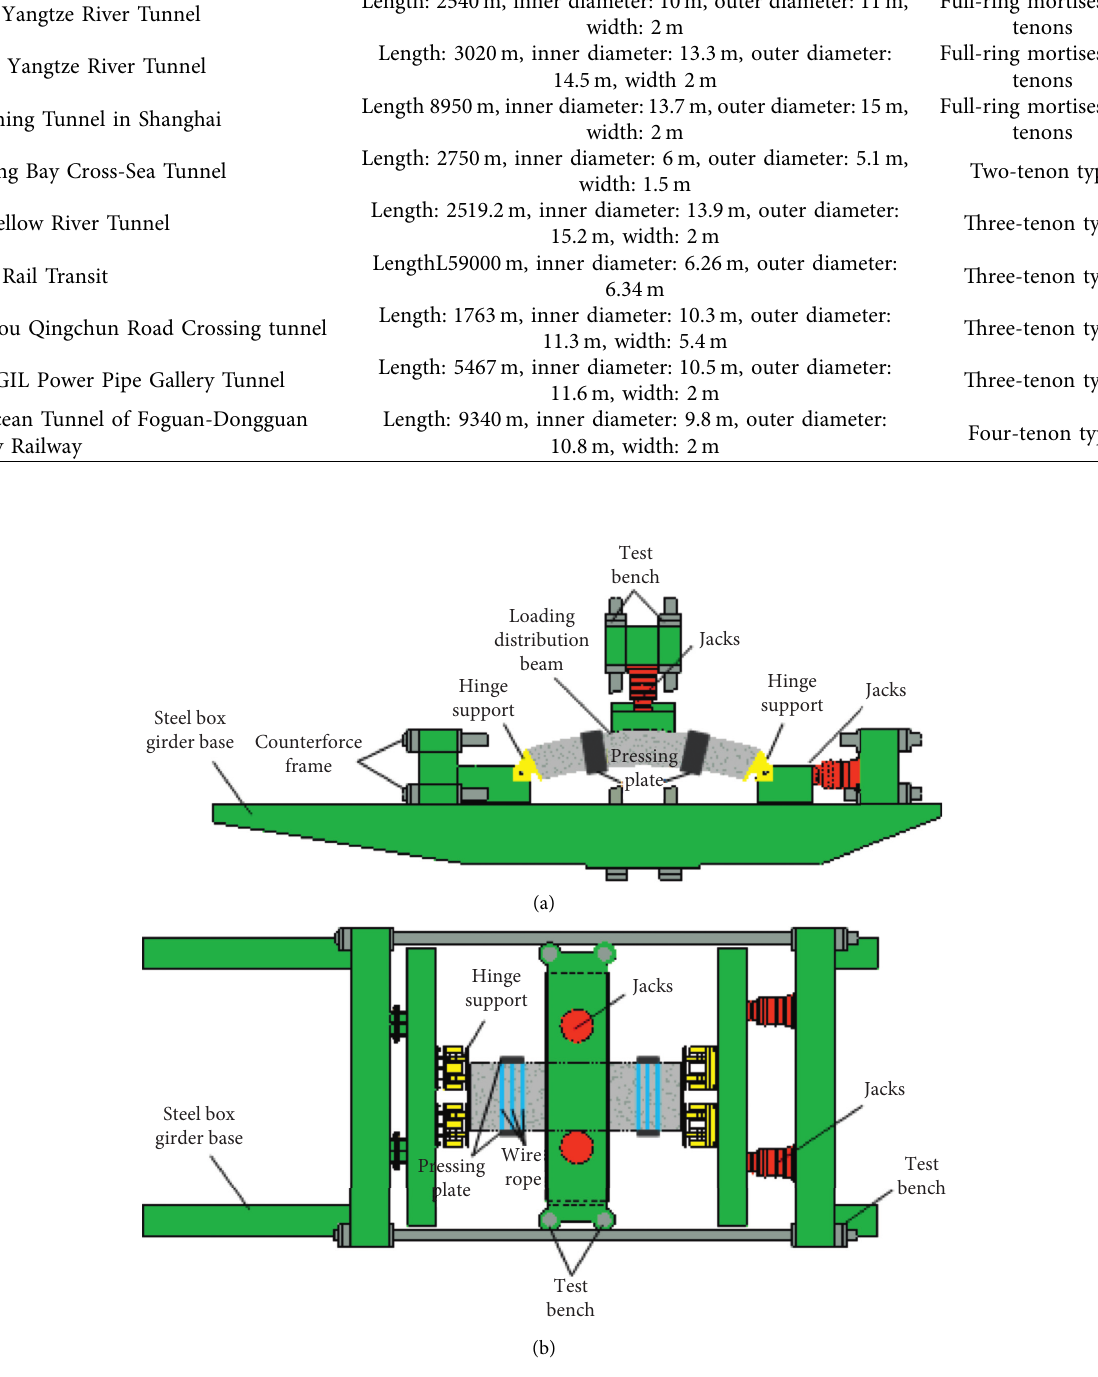
Figure 1: Three-dimensional diagram of pipe slice loading. (a) Front view. (b) Top circumferential bolts M36 in the segment structure and (A) Sutong GIL Power Pipe Gallery Tunnel Project: The 22 longitudinal bolts M40 between the rings. The angle tunnel structure uses a C60 concrete pouring segment between the longitudinal bolts is 16.3636 ° (Figure 2(a)). lining structure, with an outer diameter of 11.6 m, an inner diameter of 10.5 m, a width of 2 m, and a (B) The Shiziyang Tunnel Project of the Foshan In- thickness of 0.55 m. There are a total of 24 tercity Railway: The tunnel structure uses a C60